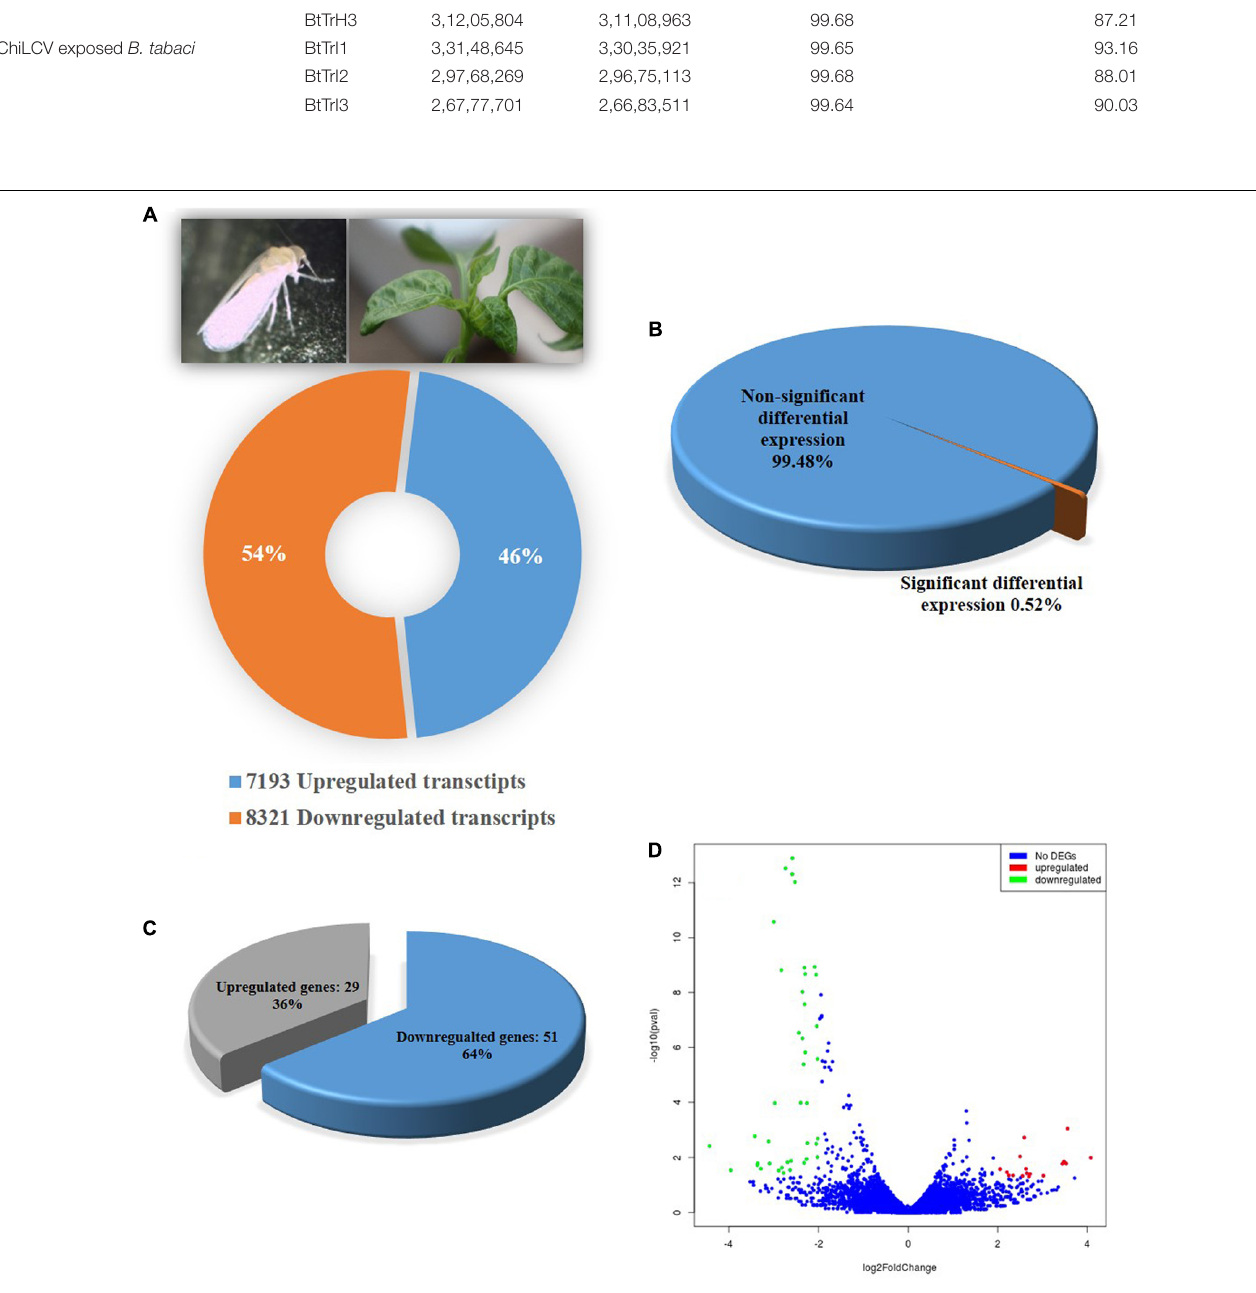
FIGURE 1 | Differential gene expression of B. tabaci Asia II1 in response to ChiLCV infection. (A) Percentage of upregulated and down-regulated transcripts; (B) Percentage differentially expressed genes of B. tabaci at the expression level of ≥ log 2 2-fold and p -value ≤ 0.05; (C) Proportion of differentially expressed genes (DEGs) in RNA-Seq analysis. A total of 29 DEGs were found upregulated while 51 were downregulated; (D) Volcano plot of DEGs. The x-axis shows the fold change in gene expression between different samples, and the y-axis shows the statistical significance of the differences. Significantly up- and downregulated genes with log 2 FC ≥ 2 are highlighted in red and green, respectively. The blue dots represent non-significant DEGs.